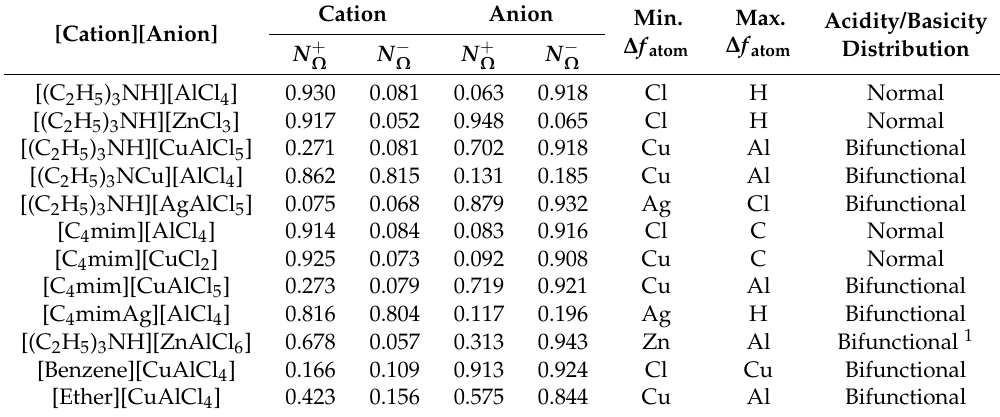
Table 4. Electrophilic ( N + Ω ) and nucleophilic ( N − Ω ) Fukui function values over the cations and anions for the studied ILs